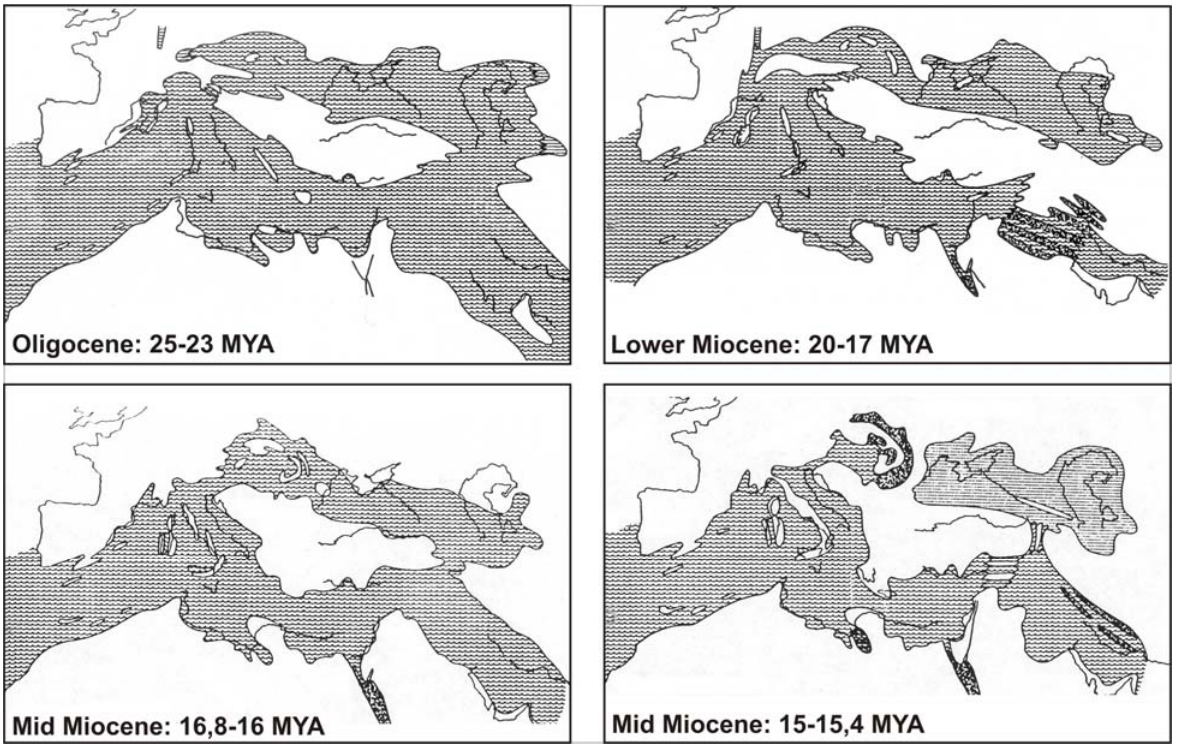
Figure 1. Palaeogegraphic reconstruction of the Mediterranean until the Mid Miocene after [3].